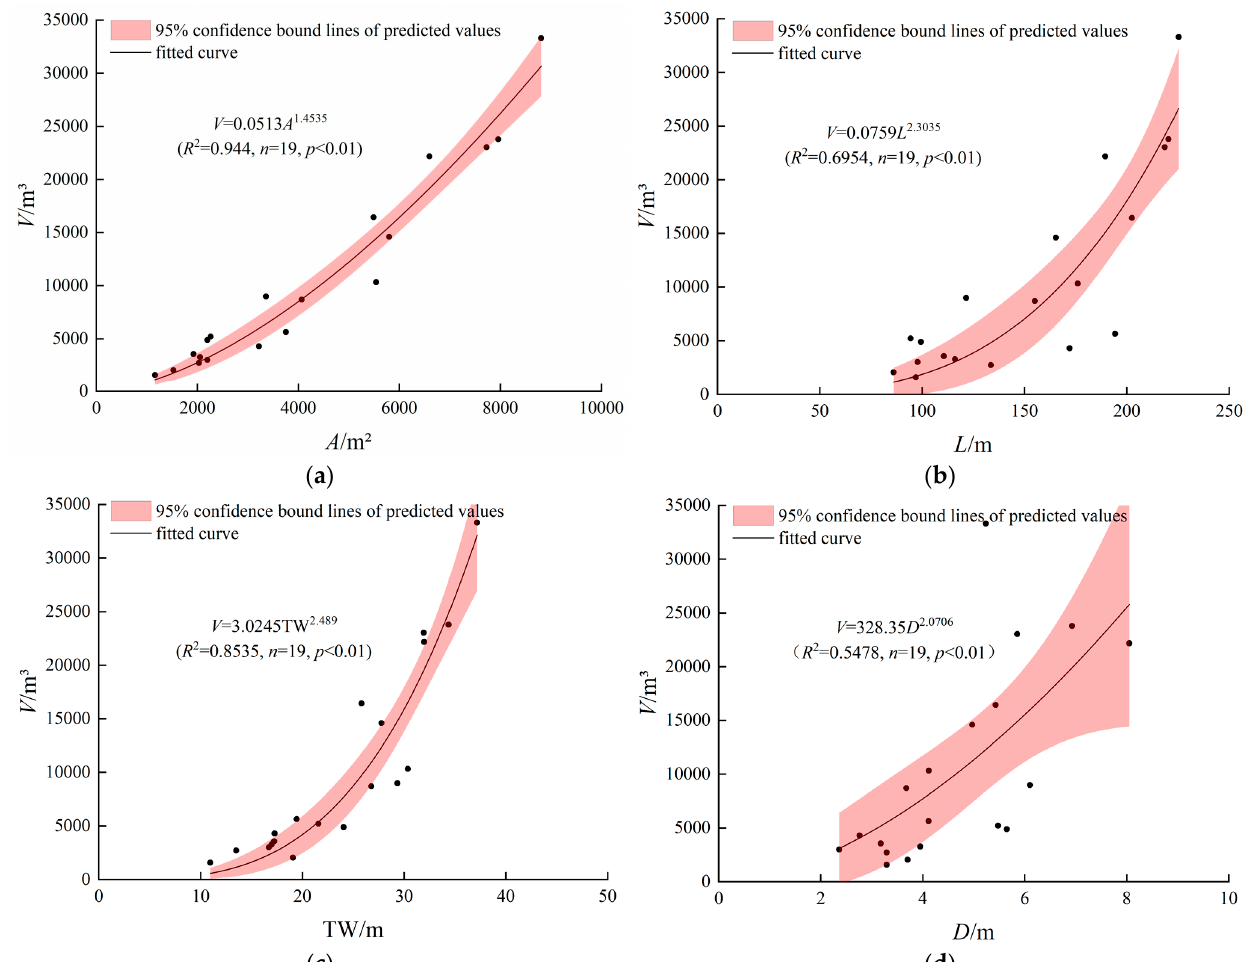
Figure 9. Relation between gully volume ( V ) and the main parameters by UAV RS imagery interpretation: ( a ) Gully volume—area relation; ( b ) Gully volume—length relation; ( c ) Gully volume—top width relation; ( d ) Gully volume—depth relation.